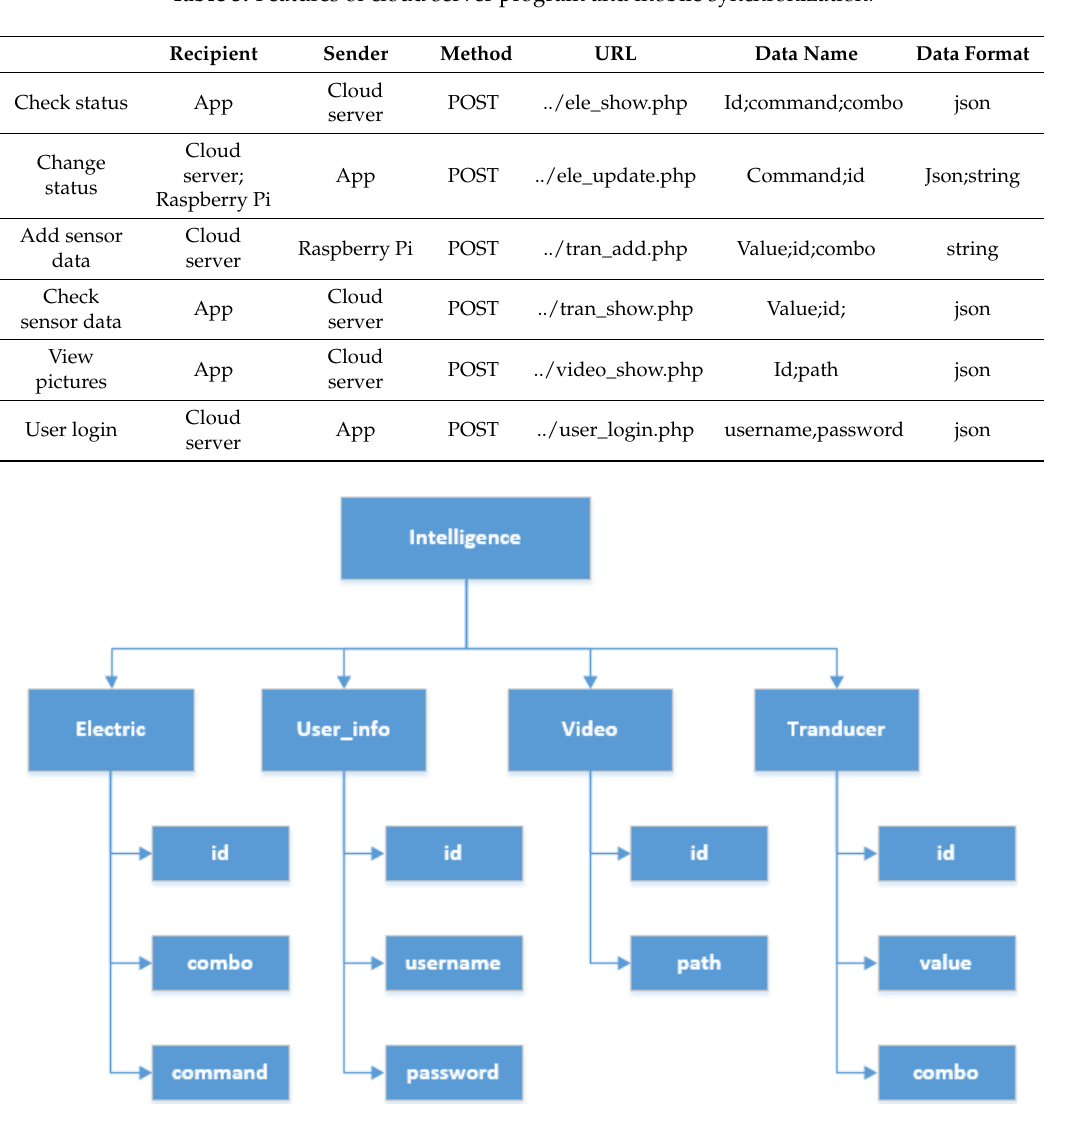
Figure 17. Detailed segments and architecture of the cloud database.